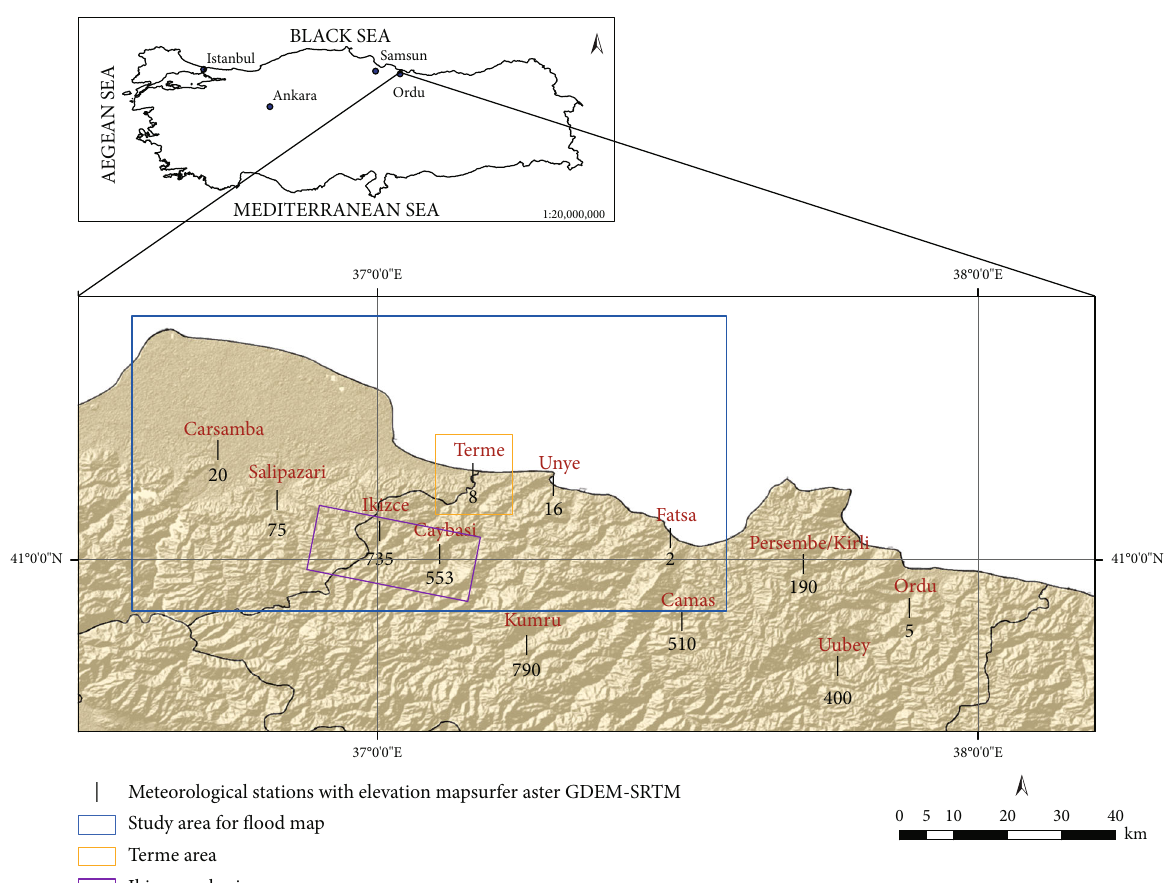
Figure 1: Location of the study area and subareas used for evaluation of the resulting fl ood map (study area coordinates: upper left: 36 ° 35 ′ 13 ″ E, 41 ° 25 ′ 01 ″ N; lower right: 37 ° 36 ′ 11 ″ E, 40 ° 47 ′ 45 ″